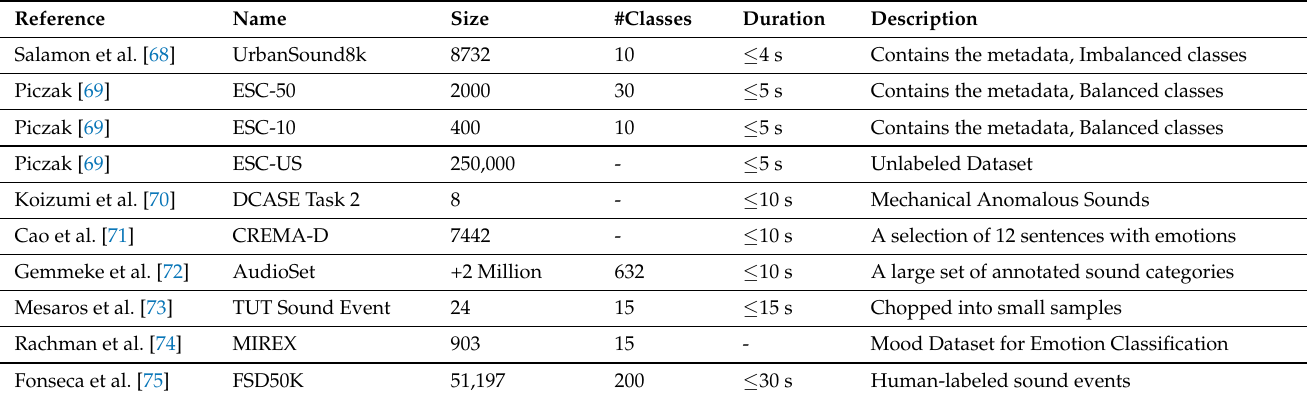
Table 8. Summary of the urban sound datasets found in this literature